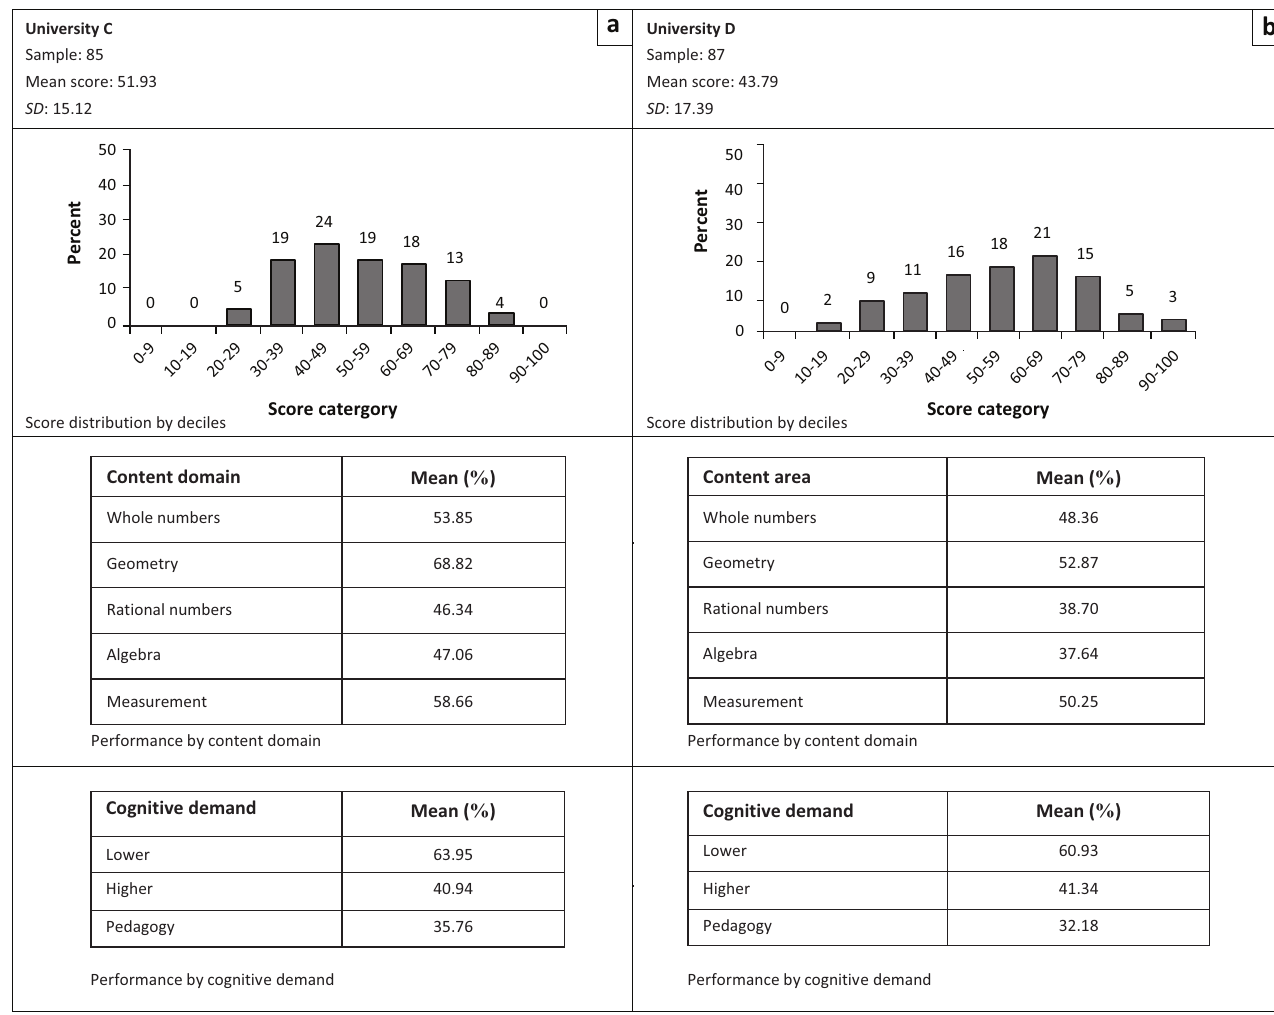
FIGURE 8: (a) Fourth-year student 2018 performance for University C, (b) Fourth-year student 2018 performance for University D.